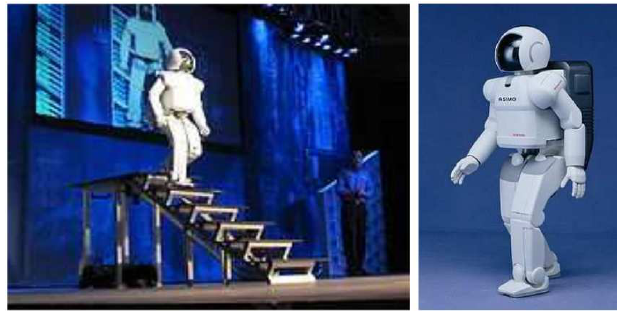
Figure 4. A robot walks down stairs (Honda ASIMO, courtesy of Wikipedia).